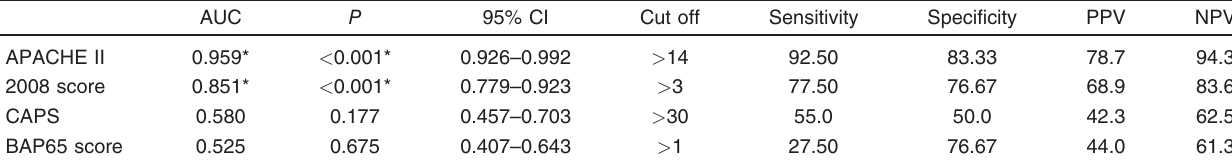
Table 4 Agreement (sensitivity and specificity) for Acute Physiology and Chronic Health Evaluation II, CAPS, BAP65, and 2008 scores to predict mechanical ventilation patients AUC